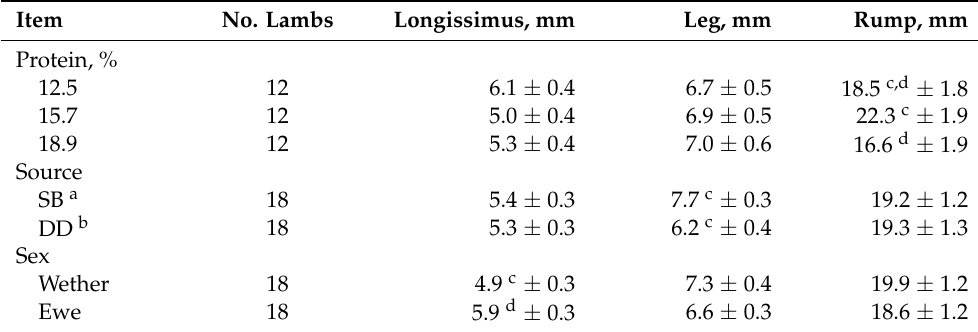
Table 3. Least squares means and standard errors for the thickness of subcutaneous fat over longis- simus, leg, and rump